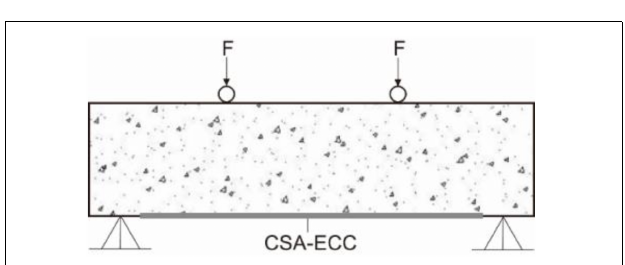
FIGURE 4 | Testing schematics for concrete beam reinforcement.